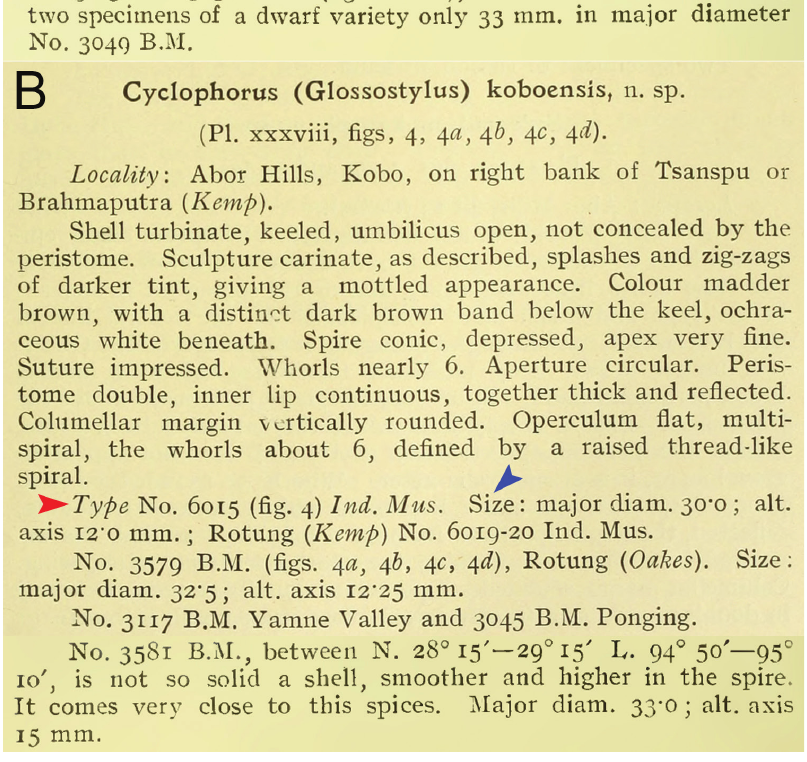
Figure 2. Original descriptions of A Cyclophorus aborensis and B Cyclophorus ( Glossostylus ) koboensis from Godwin-Austen (1915). Red arrows indicate the annotation of “Type”. Blue arrows indicate the set of measurements. Credit: The Biodiversity Heritage